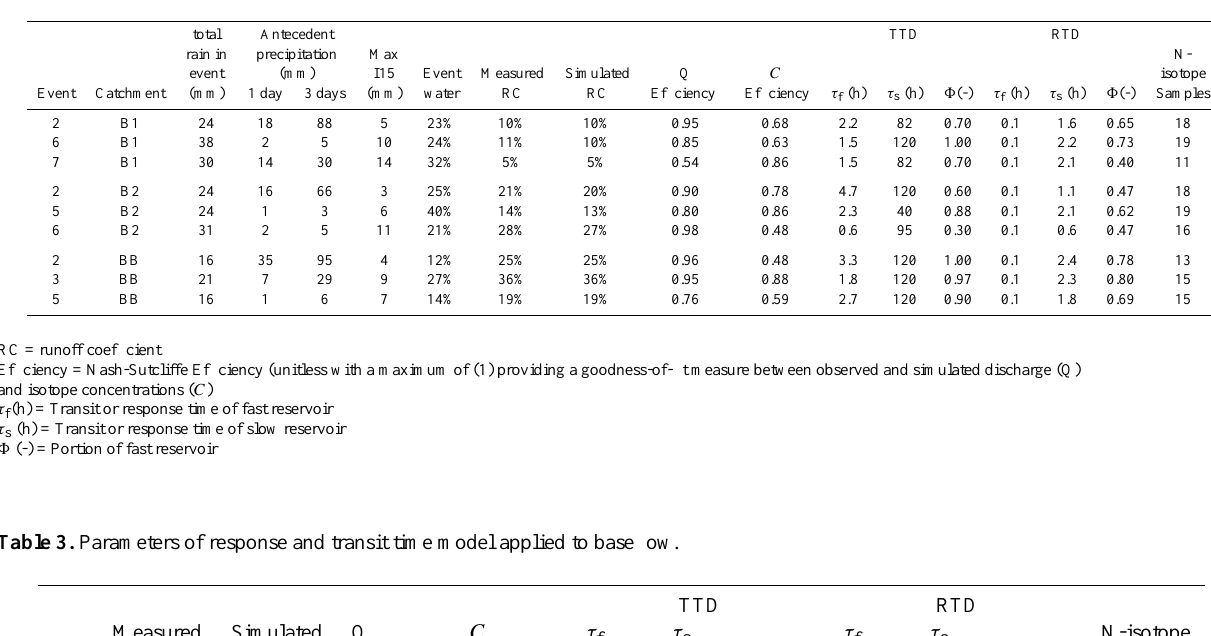
Table 2. Parameters of response and transit time model applied to individual events.